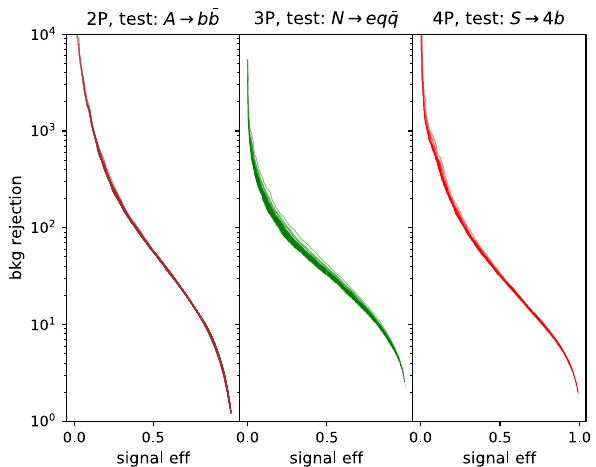
Fig. 7 Variability in the performance of 2P, 3P and 4P taggers (from left to right, respectively), obtained from B = 50 bootstrap samples of the original